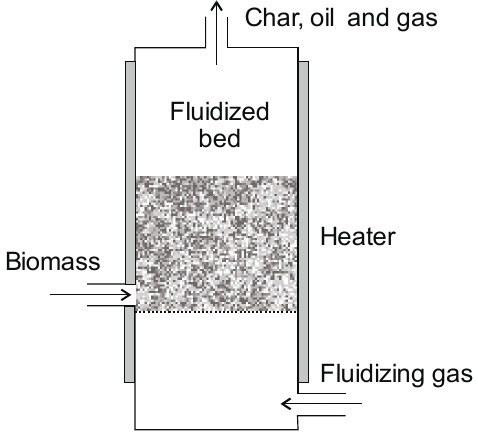
Figure 14. Bubbling Fluidized Bed (BFB) (adopted from [136]).